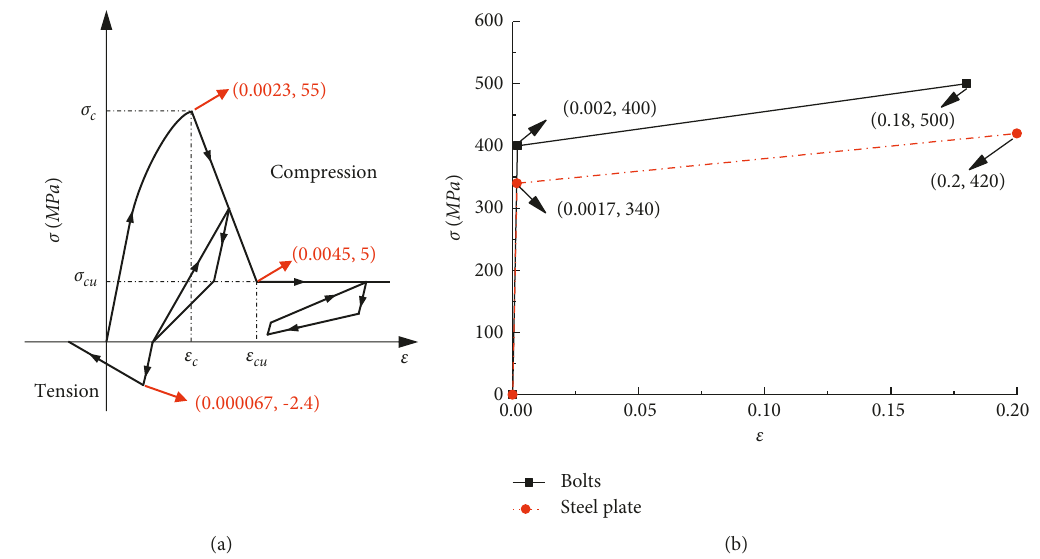
Figure 2: Stress-strain of components. (a) Concrete. (b) Bolts and steel